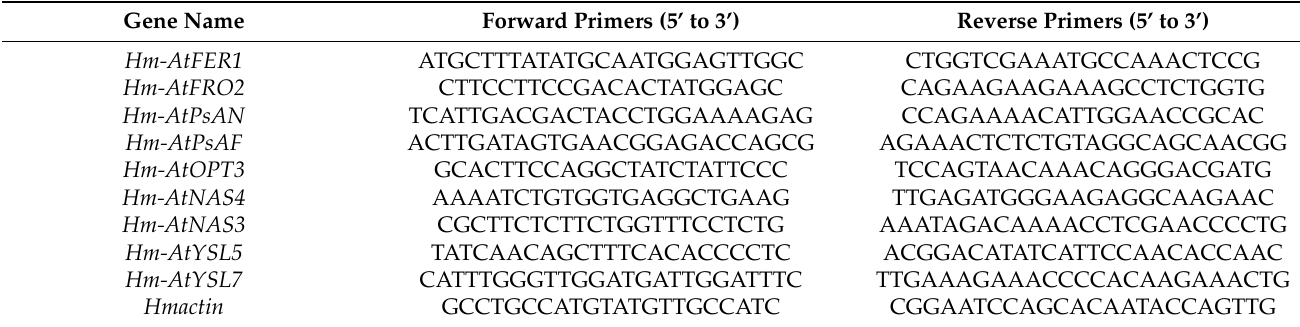
Table 2. List of qPCR primers used in this